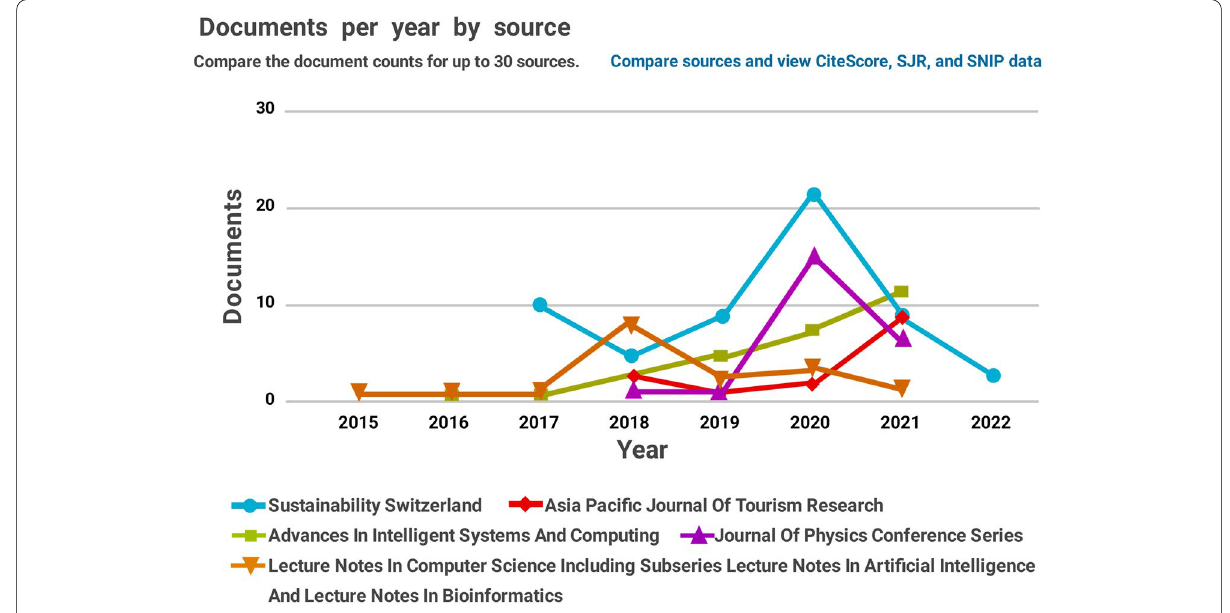
Fig. 4 Documents per year by source related to ‘smart